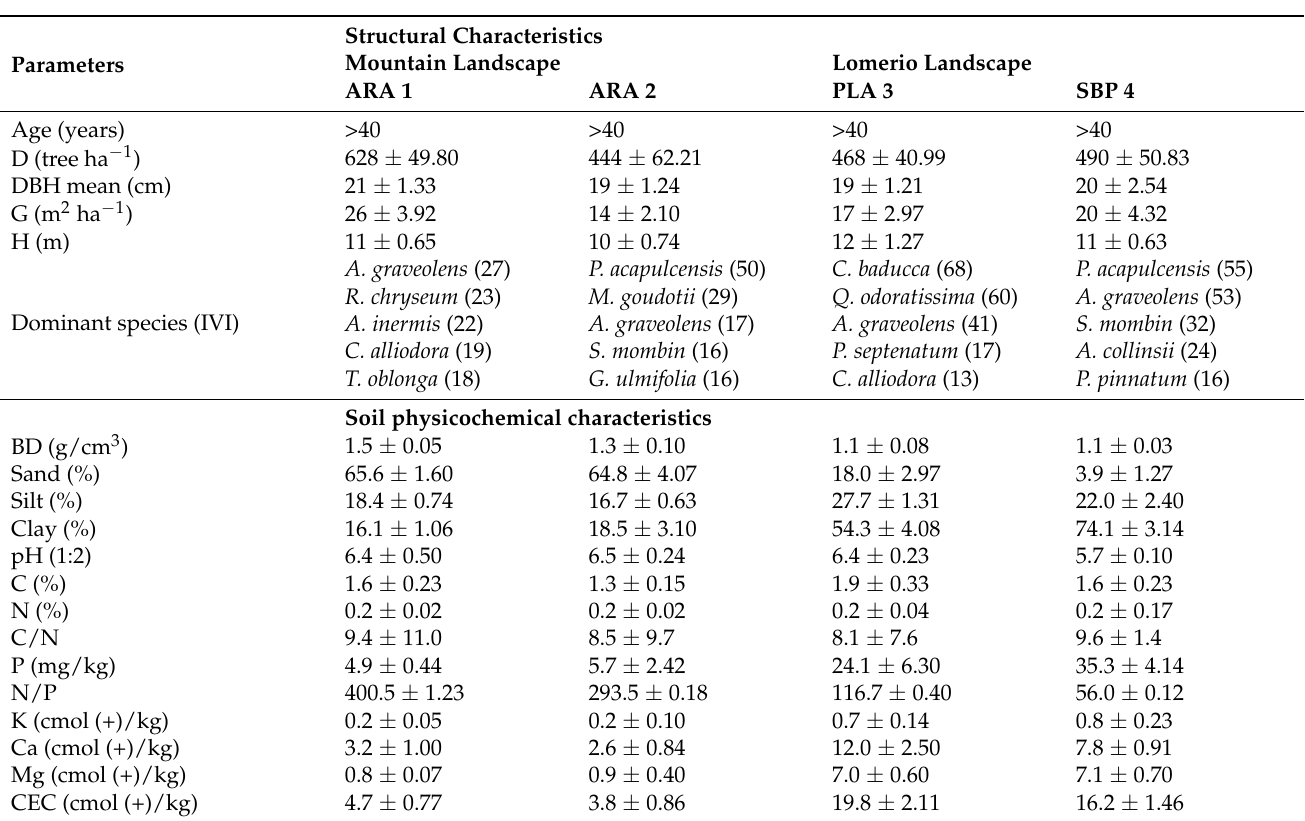
Table 1. Structural characteristics and physicochemical properties of soils (0–20 cm) in TDFs in Magdalena, Colombia. Mean ± SE ( n = 9 plots for Mountain landscapes, and n = 12 plots for Lomerio landscapes). D: density (trees ha − 1 ) of trees with DBH (tree diameter at breast height) > 10